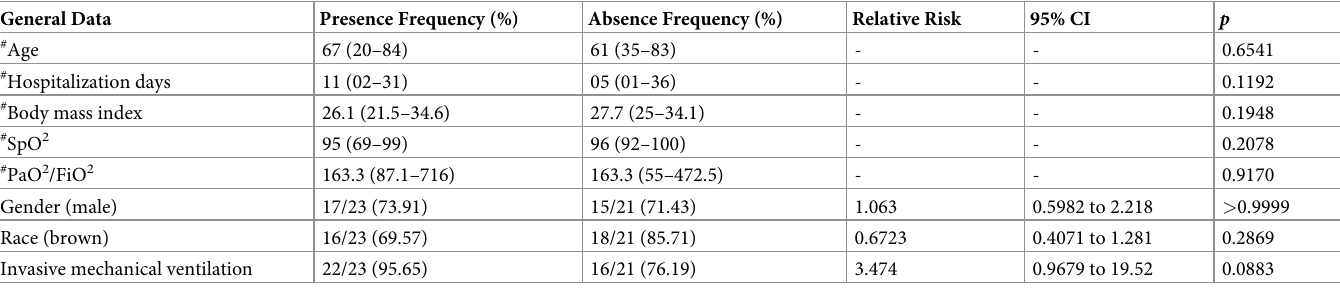
Table 1. Assessment of general data between study groups. General